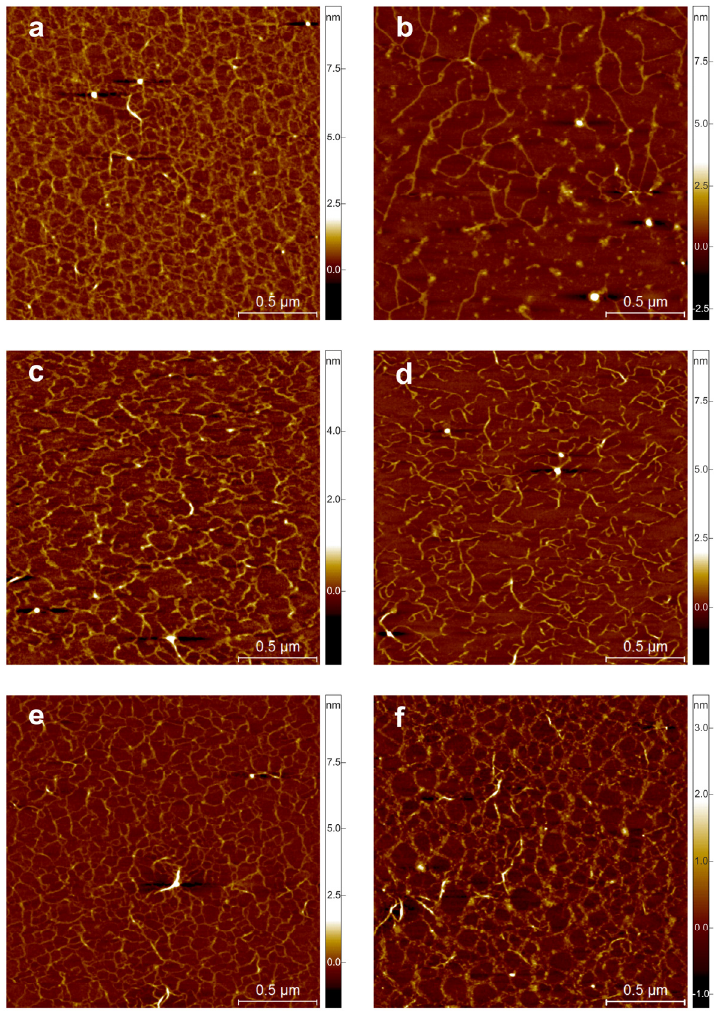
Figure 4. AFM height images of pectin extracted with ammonium oxalate during cold storage; ( a )—organic cultivation on raised beds T0, ( b )—organic cultivation on raised beds T12, ( c )—organic cultivation in a flat-planted plot T0, ( d )—organic cultivation in a flat-planted plot T12, ( e )—conventional cultivation in a flat-planted plot T0, ( f )—conventional cultivation in a flat-planted plot T12. Table 4. Topographic parameters of pectin molecules extracted from fresh (T0) and stored (T12) strawberries with ammonium oxalate. The Percentage of Pectin Molecules Characterized by Different Fibre Lengths (% of Total Fibre Length) Range of Fibre Length [nm] 0–100